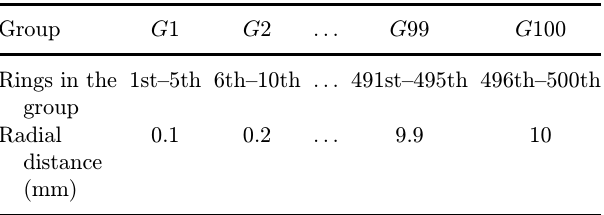
Table 1. The method of grouping the rings. Group